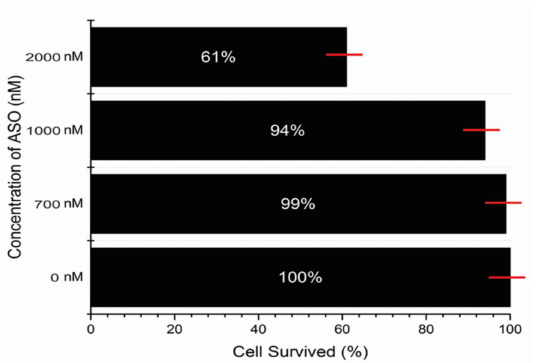
Figure 4. Probing the pVEC-ASO’s toxicity level in a lung cancer human cell line. In a concentra- tion of 2000 nM of pVEC-ASO-1, the survival of the cell line is 61%. In the next concentration of 1000 nM, the survival of the cell line is 94%. At a concentration of 700 nM, the survival of the cell line is 99%. In the absence of pVEC-ASO-1, the survival of the cell line is 100%.